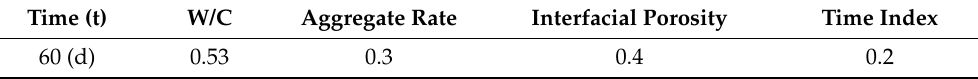
Table 2. Verifies the model parameters.